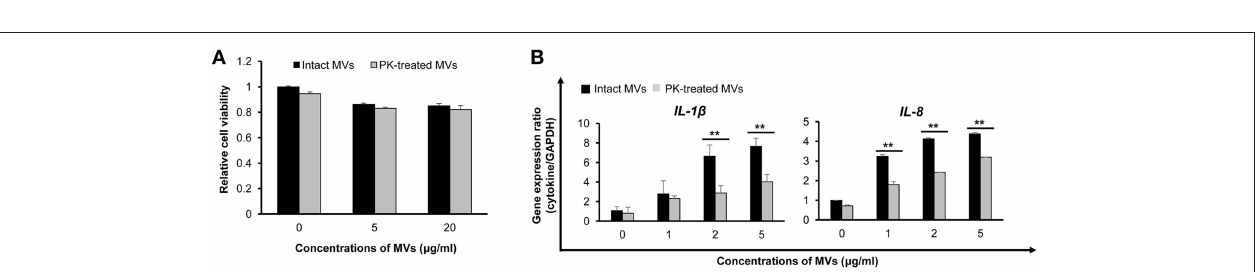
FIGURE 5 | Host cell responses to proteinase K (PK)-treated E. faecium MVs. (A) Caco-2 cells were incubated with intact or PK-treated MVs/BHI for 24h and cell viability was determined using an MTT assay. Data are presented as the mean ± SD of three independent experiments. (B) Cells were incubated with intact or PK-treated MVs/BHI for 3h and gene expression was assessed via qPCR. Data are presented as the mean ± SD of three independent experiments. ** P < 0.01 comparing intact and PK-treated